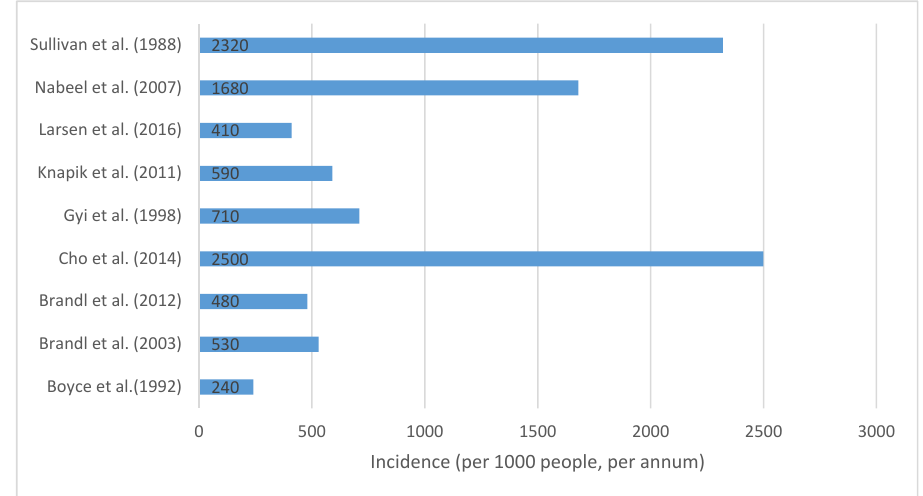
Figure 2. Injury incidence rates, by study (injuries per 1000 personnel per annum). Injury incidence rates are reported here only for studies which provided the required data to make these rates